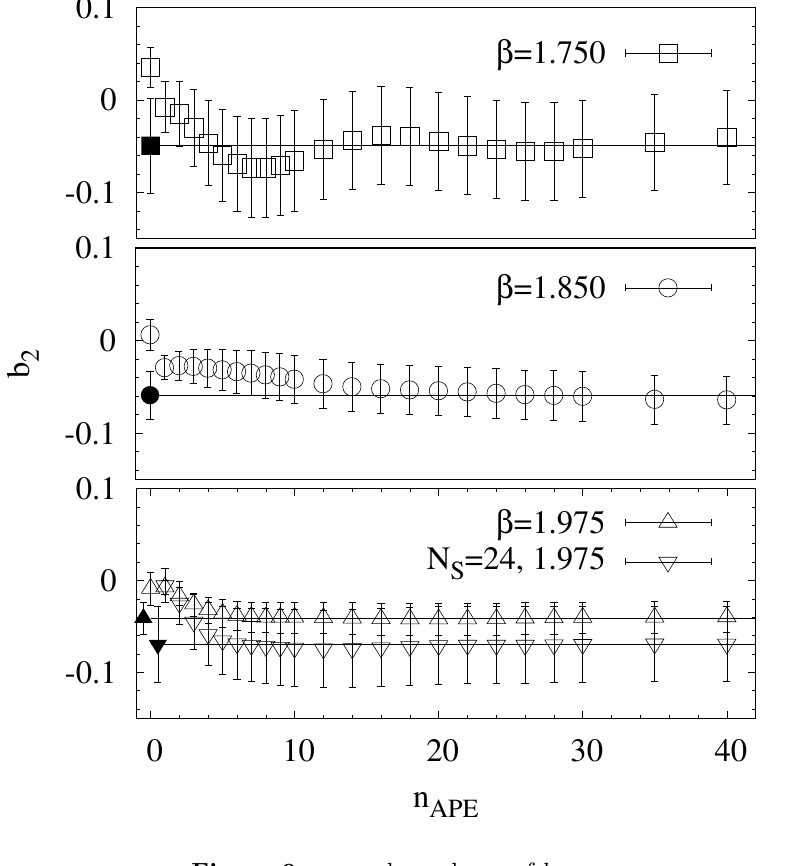
Figure 9 . n APE dependence of b 2 .